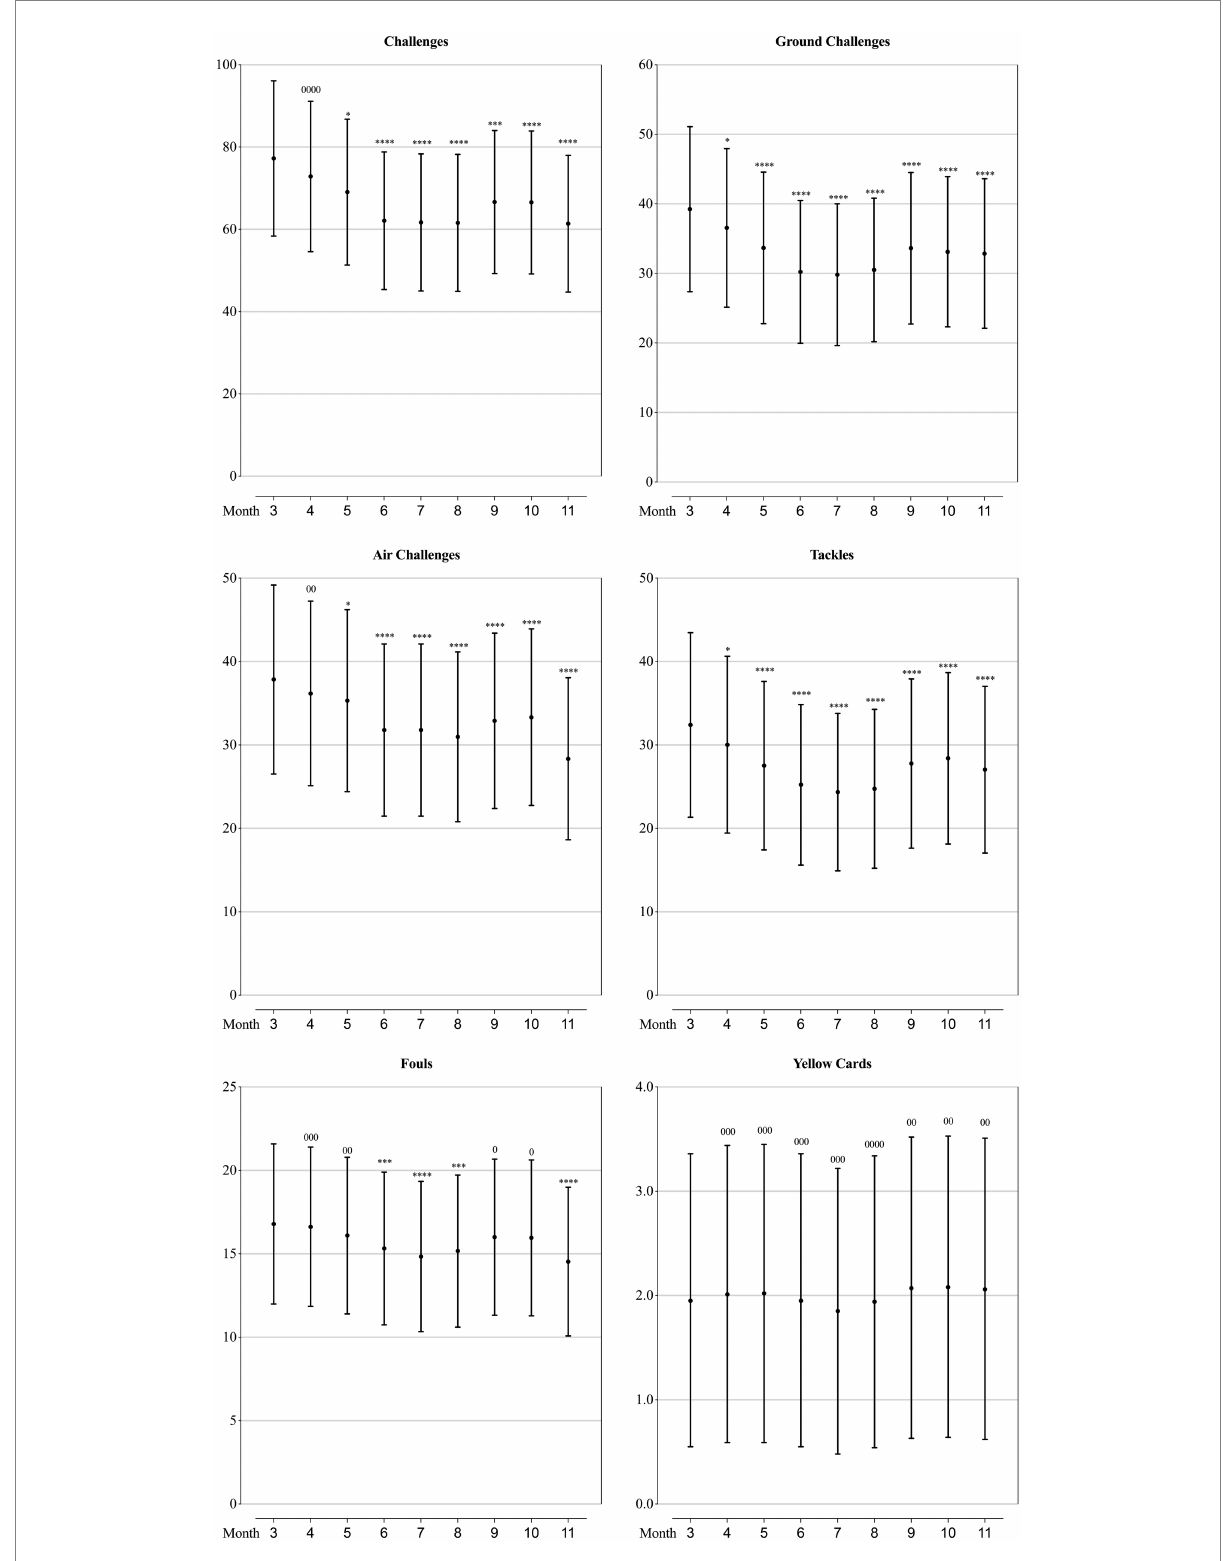
FIGURE 2 Values of goal-scoring related parameters in each month of a season for the teams competing in the CSL in 2012-2019 estimated from the generalised mixed linear modelling. Filled dots are the means. Error bars are the standard deviations. Symbols “0” and “*” stands for trivial and negative change from the value of March (month “3”). Number of symbols indicate the likelihood for the magnitude of the true effect as follows: 1-possible; 2-likely; 3-very likely; 4-most